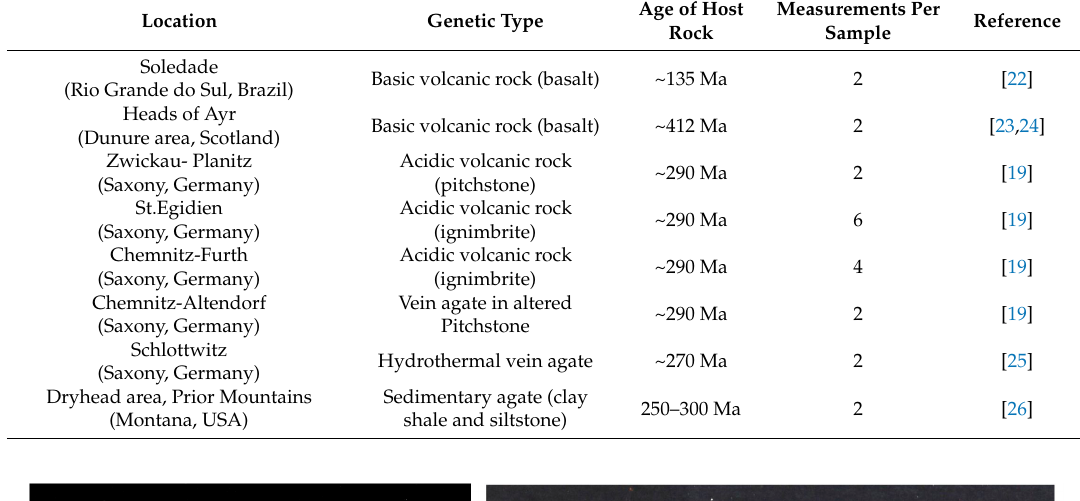
Table 1. Compilation of the investigated agate samples and their genetic types.